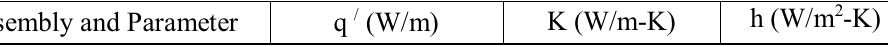
Table II. Heat transfer